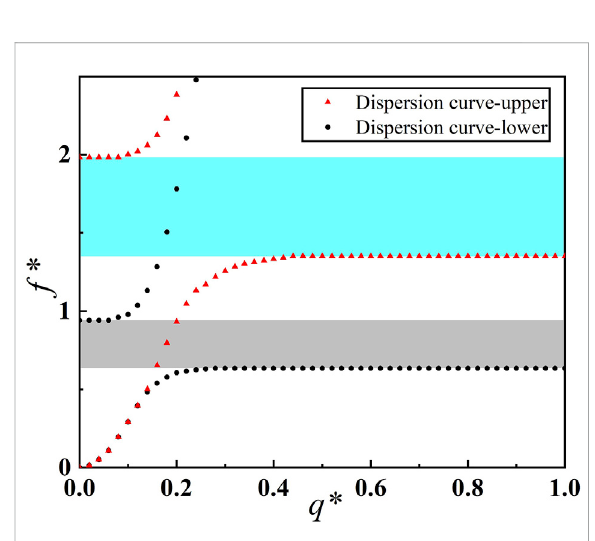
FIGURE 9 The band structure of the QZS locally resonant metamaterial with introduced geometric